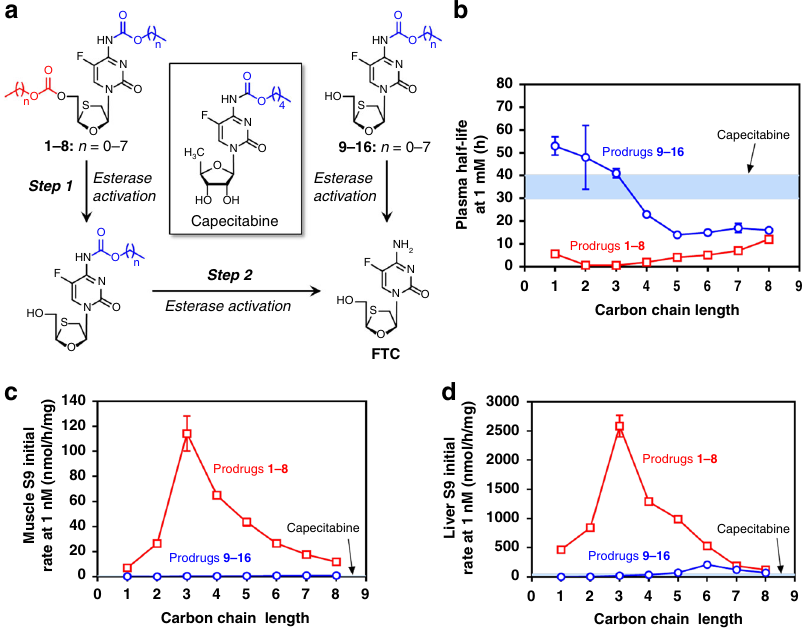
Fig. 2 In vitro metabolism of emtrictabin (FTC) prodrugs under physiologically relevant conditions. a Initial rates of esterase-mediated hydrolysis of 5 ’ - carbonate (1 mM, 1 – 8 ) to generate corresponding carbamates, and initial rates of hydrolysis of carbamates (1 mM, 9 – 16 ), resembling capecitabine, to generate FTC was monitored in undiluted human plasma ( b ), muscle S9 ( c ), and liver S9 ( d ) fractions. The light blue band represents the mean ± SD for carbamate cleavage from capecitabine